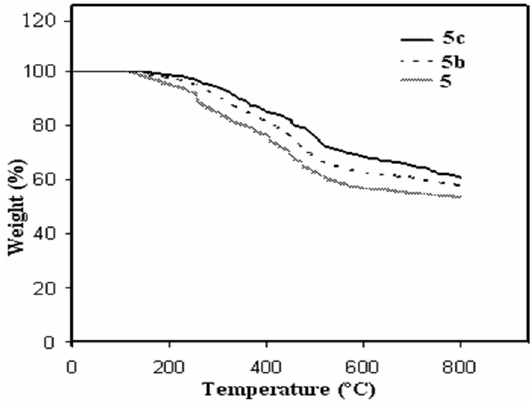
Figure 6. Uv-Vis spectra of PA 5, PA-nanocomposite films 5a–5c.